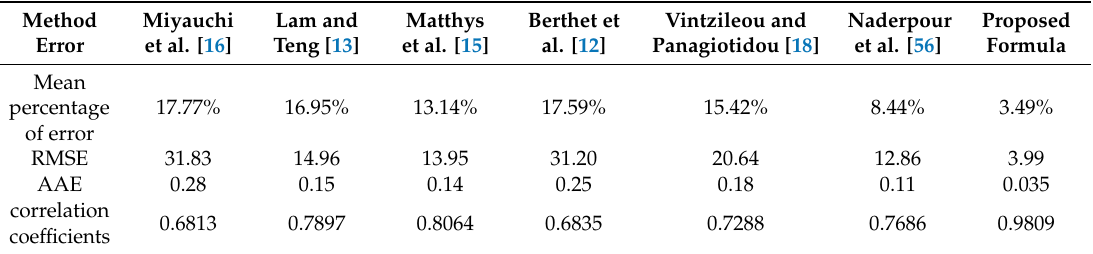
Table 4. Comparison between di ff erent studied